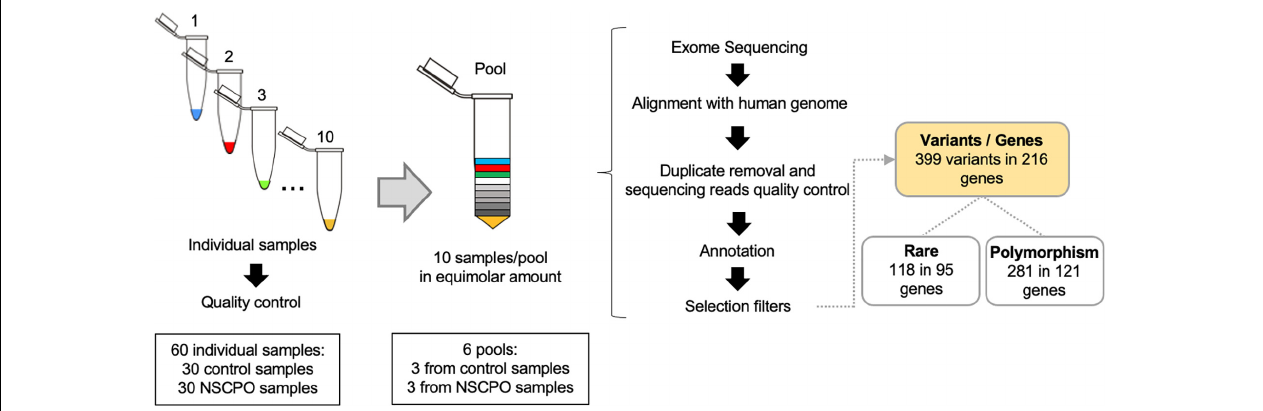
FIGURE 1 | Workflow of whole-exome pool sequencing applied to 30 samples of patients with non-syndromic cleft palate only (NSCPO) and 30 healthy controls. After sequencing and bioinformatic analyses, 399 variants distributed in 216 different genes were found, with 118 rare variants in 95 genes and 281 polymorphisms in 121